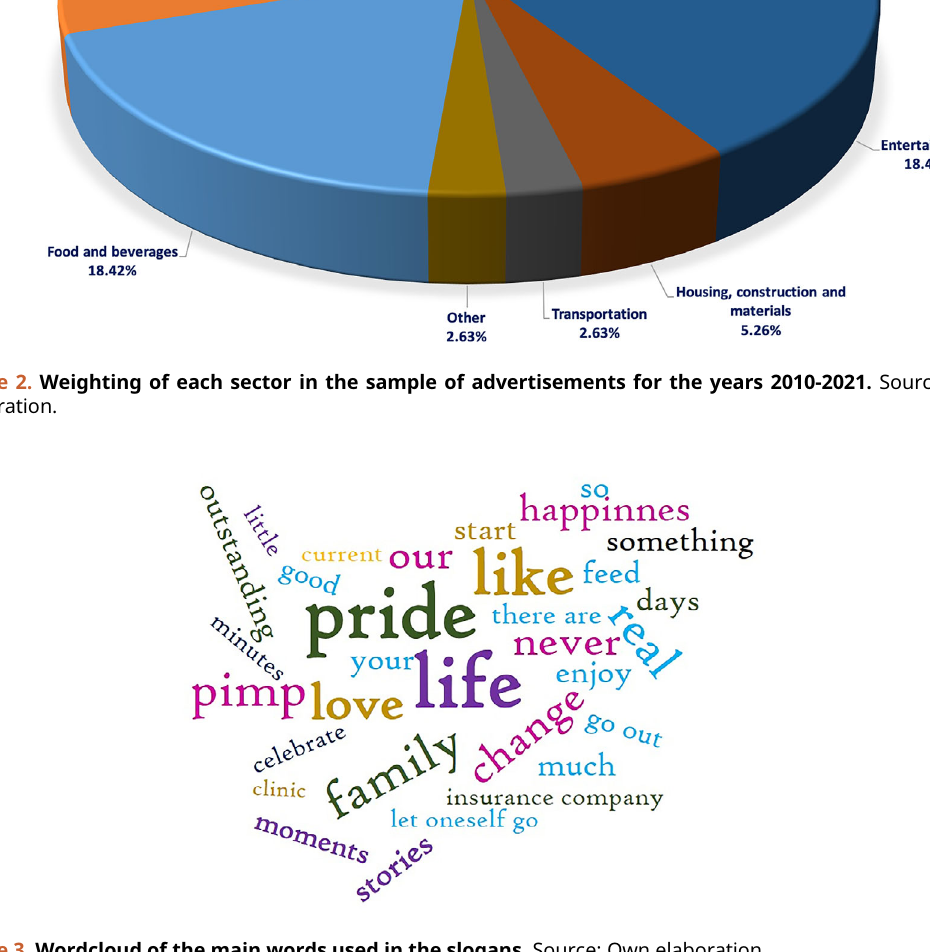
Figure 3. Wordcloud of the main words used in the slogans. Source: Own